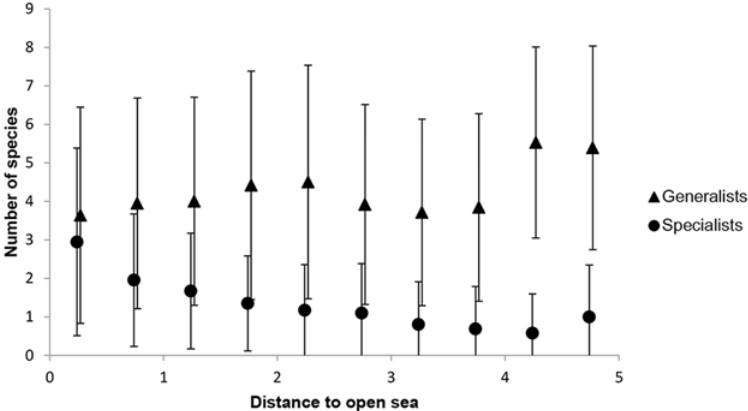
Fig 4. Mean number of species ( ± 1 standard deviation) in relation to distance to open sea. Data are grouped with regard to distance to open sea (mean standardised, x-axis value ± 0.25, respectively). Sample sizes are (from left to right) 1879, 931, 683, 531, 247, 160, 112, 51, 19, 23.